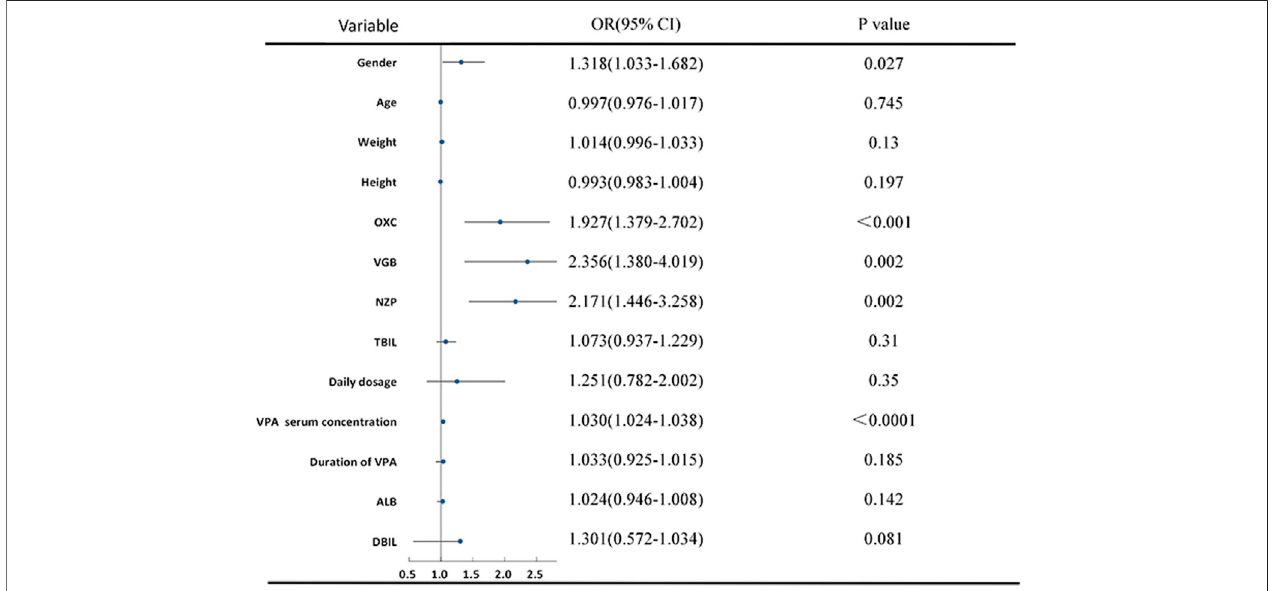
FIGURE 2 | Ordinal logistic regression analysis of predictors of VPA ef fi